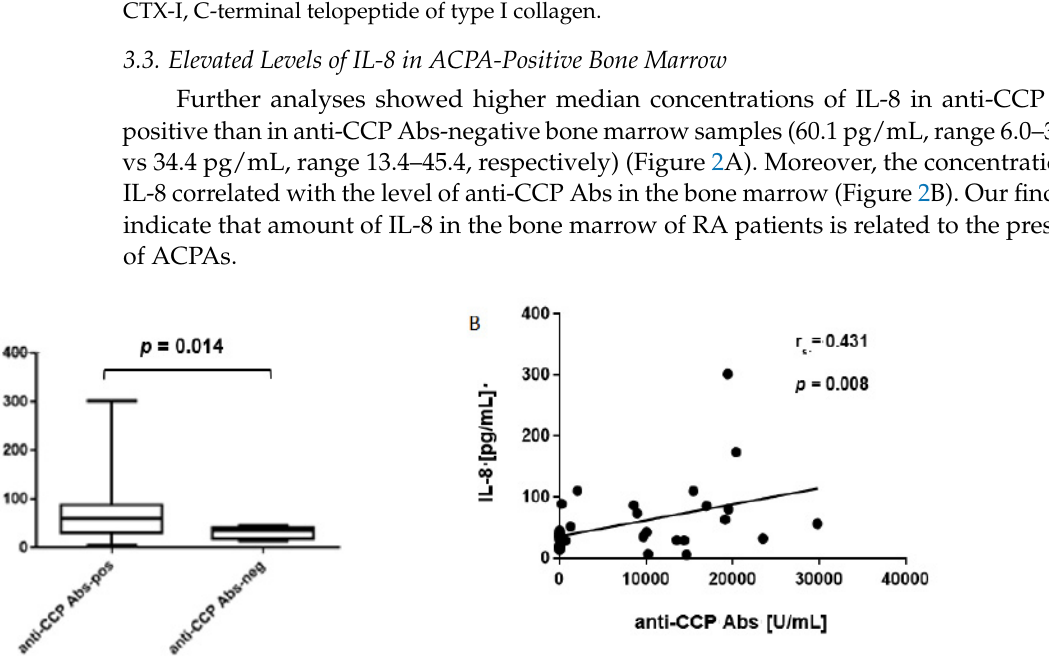
Figure 1. Concentrations of TRAP5b, cathepsin K and CTX-I in the bone marrow of RA patients. ( A – C ) Anti-cyclic citrullinated peptides antibodies-positive (anti-CCP Abs-pos)/anti-cyclic citrullinated peptides antibodies-negative (anti-CCP Abs-neg) bone marrow samples: n = 20/18 ( A ), n = 19/17 ( B ) and n = 22/20 ( C ). Comparisons were performed using two-tailed Student’s t-test (A and C) or two-tailed Mann–Whitney U test ( B ). TRAP5b, tartrate-resistant acid phosphatase 5b; CTX-I, C-terminal telopeptide of type I collagen.